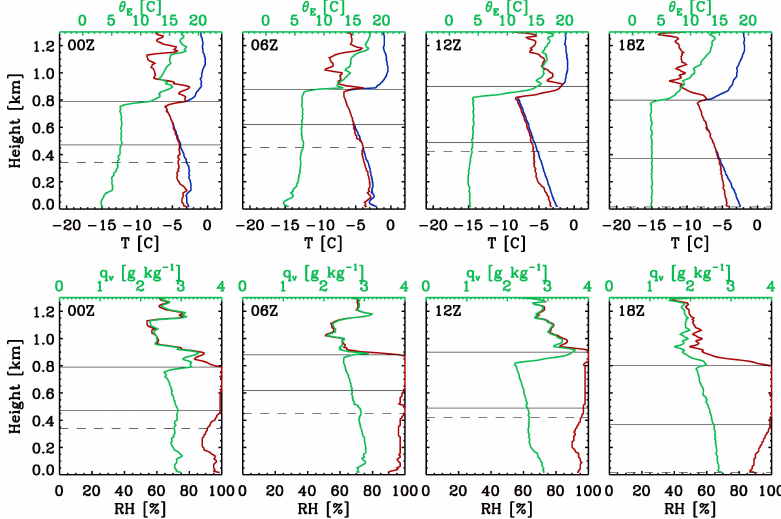
Fig. 7. As in Fig. 4, but for 0Z, 6Z, 12Z, and 18Z soundings (moving left to right) on 29 August 2008 (Case